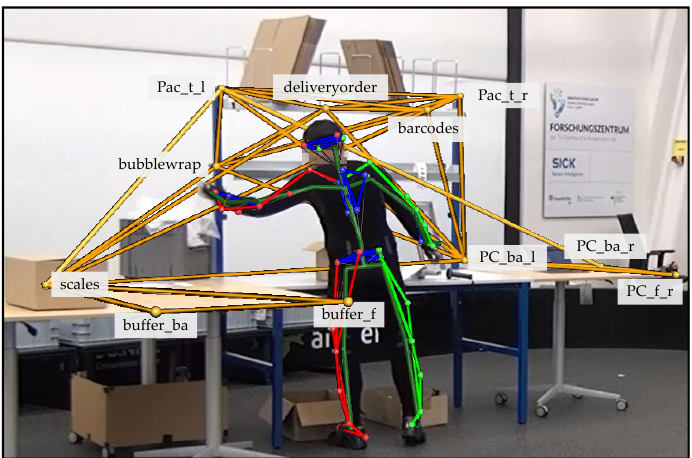
Figure 4. Marker designations of the packaging